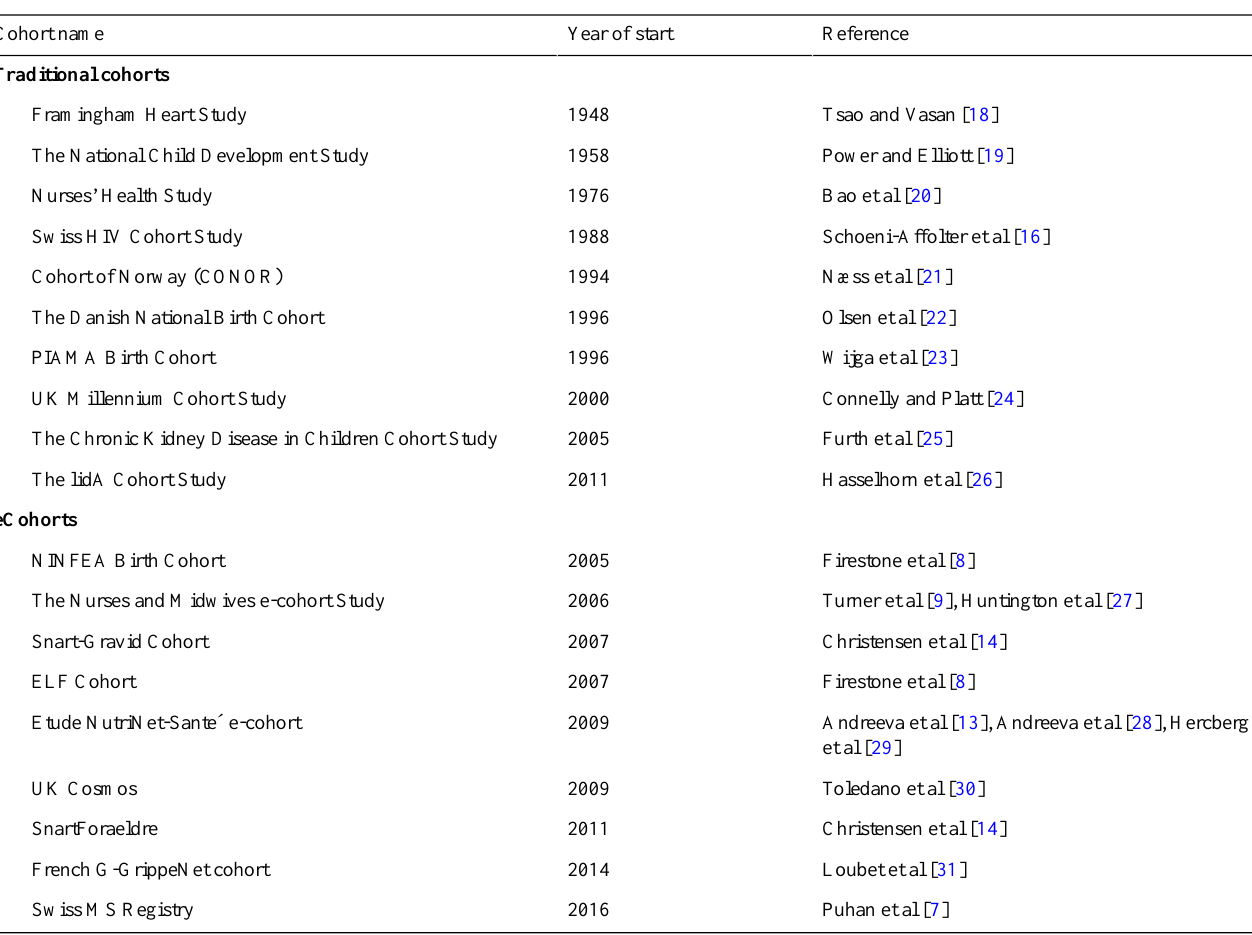
Table 1. Included cohort